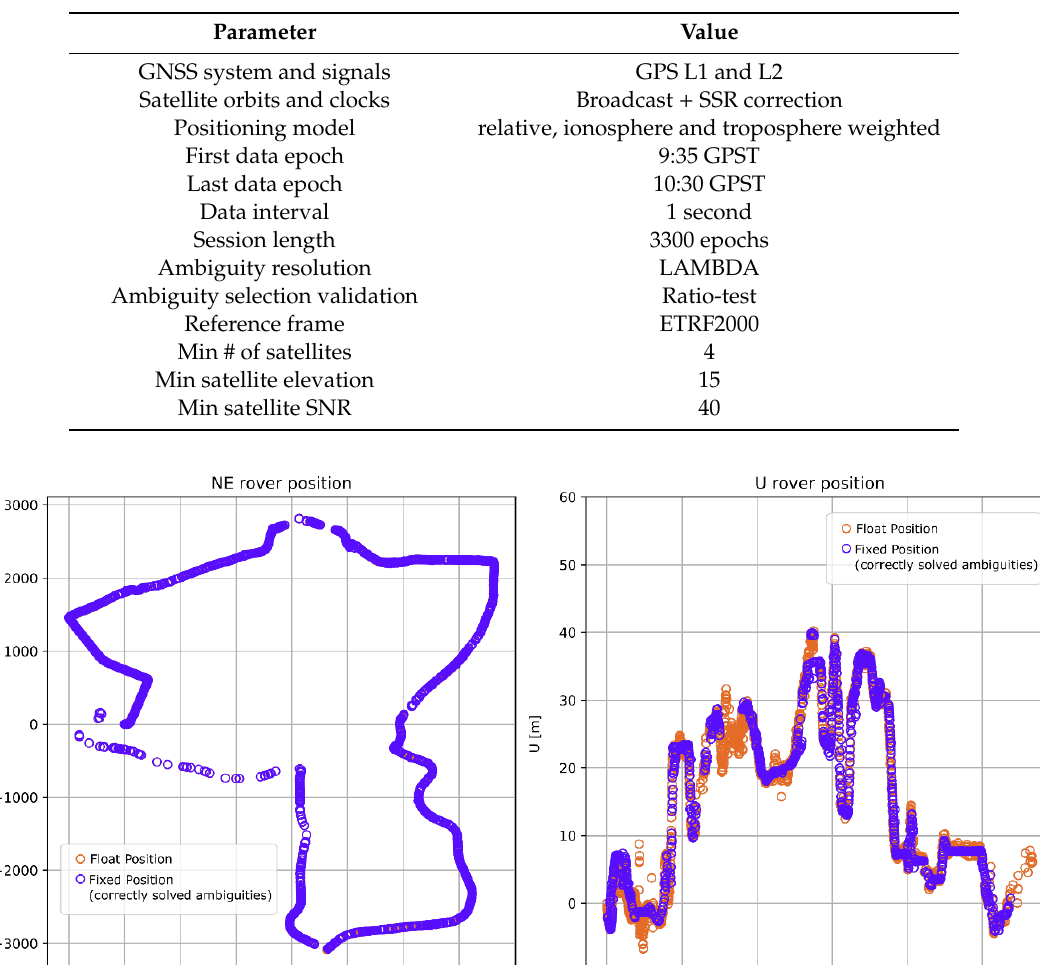
Table 2. pyGNSS real-time processing parameters.